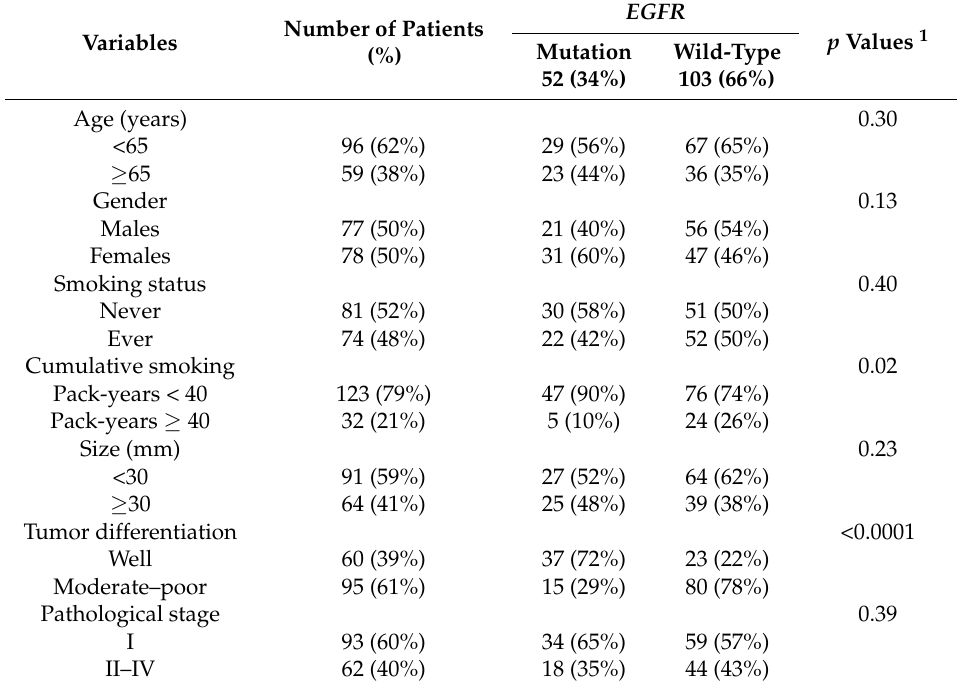
Table 1. Clinicopathological characteristics of 155 cases of lung adenocarcinoma stratified by EGFR mutation status.